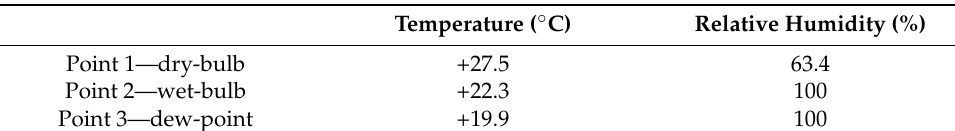
Table 1. Working conditions of processes from Figure 3 [12].